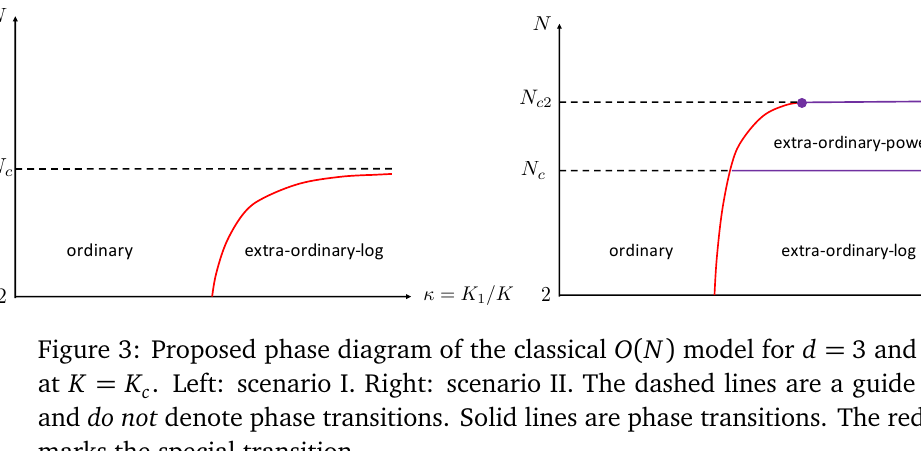
Figure 3: Proposed phase diagram of the classical O ( N ) model for d = 3 and N ≥ 2 at K = K . Left: scenario I. Right: scenario II. The dashed lines are a guide to eye c and do not denote phase transitions. Solid lines are phase transitions. The red curve marks the special